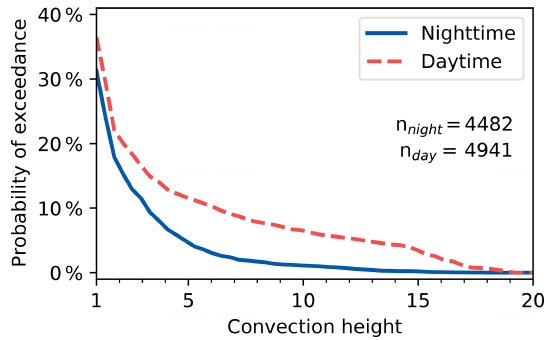
Figure 7. Cumulative probability distribution of the aerodynamic Richardson number, for nighttime data. Negative Ri A values are represented in the maximum of 78% probability of exceedance, i.e., ∼ 22% of the nighttime Ri A values are negative. Vertical line shows Ri A = 2, which was defined as the “decoupling threshold” in Bosveld et al.